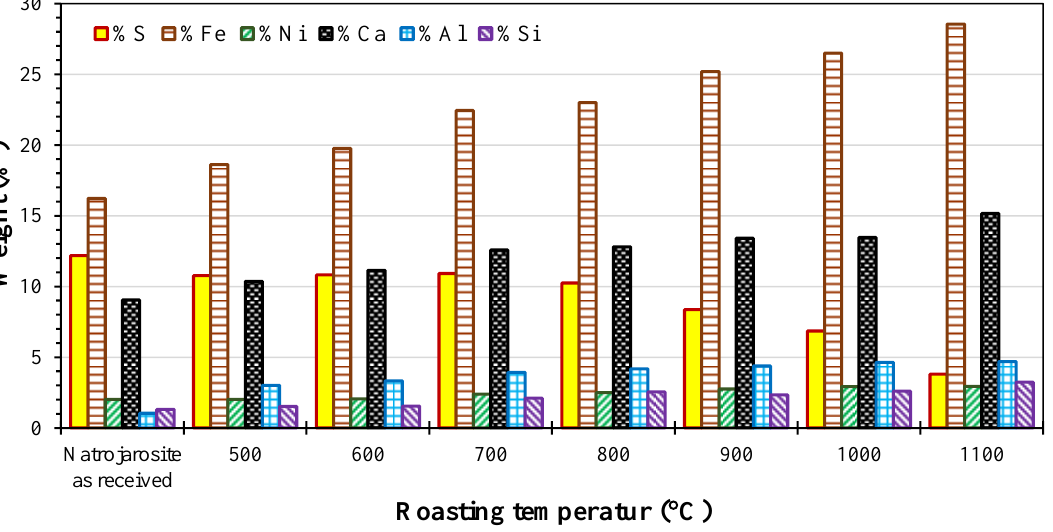
Figure 6. Changes in the contents of sulfur, iron, nickel, calcium, aluminum, and silicon after roasting at a temperature of 500–1100 ◦ C. In line with the removal of sulfur, the iron content in the jarosite residue increased from 16.23% to 28.54% and nickel content increased from 2.02% to 2.94% after being roasted at 1100 ◦ C. Similar results were observed for calcium in which its content increased from 9.06% to 15.16%. The sulfur content can be further reduced by increasing the roasting temperature, as indicated by TG/DTA results in Figure